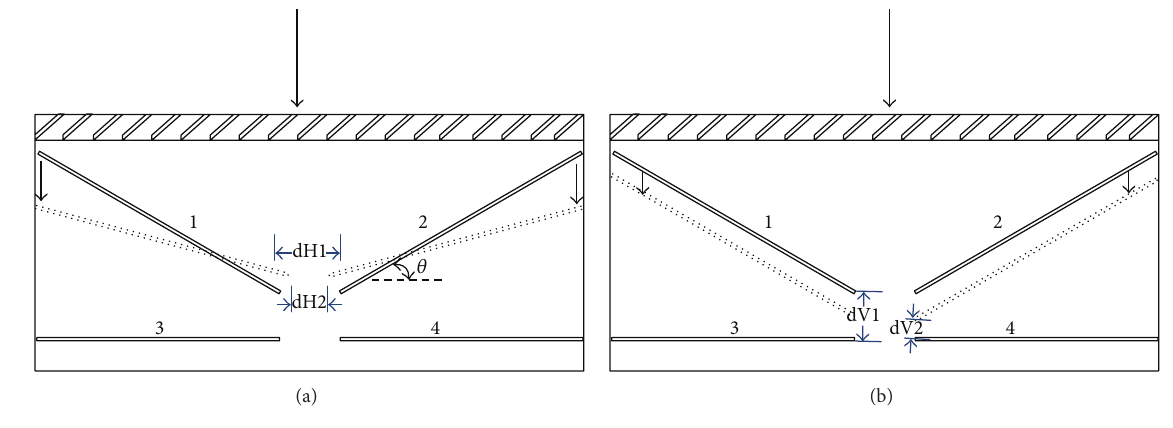
Figure 3: Possible configurations of numerical model.